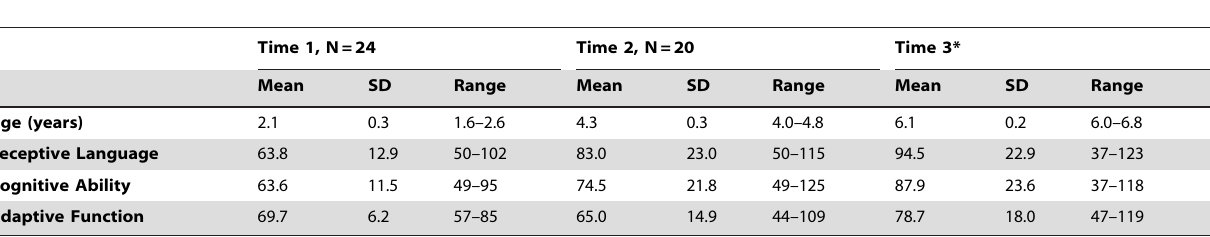
Table 4. Age and standardized behavioral measures at Time 1, Time 2, and Time